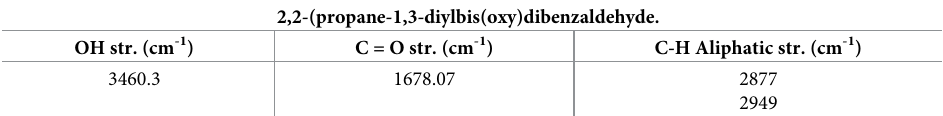
Table 1. Shows the FT-IR data of synthesized compounds 1 .